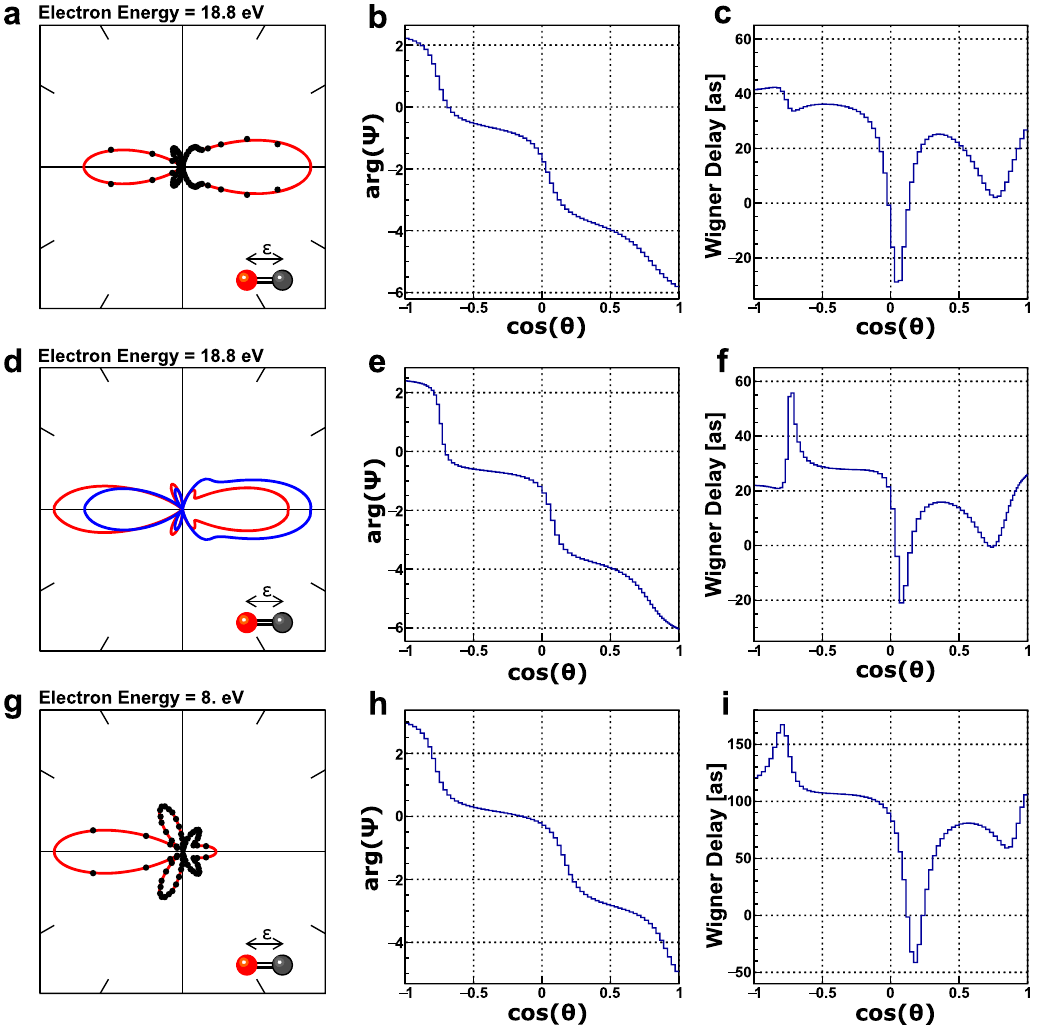
Fig. 2 Molecular-frame photoelectron angular distribution and extracted information for ε = 18.8 eV and ε = 8.0 eV. a Example of the emission pattern of a core electron emitted from the carbon atom of a CO molecule (black dots) for an electron energy of ε = 18.8 eV. The electron has been ionized by linearly-polarized synchrotron light. The molecule is oriented horizontally and parallel to the polarization axis of the photons with the emitting carbon atom pointing to the right (as depicted by the inset). The rich angular features are caused by the scattering of the emerging electron wave by the molecular (cid:1) (cid:3) potential. The statistical error bars of the data points are smaller than the markers. b The extracted phase arg Ψ ε ð θ Þ and c molecular-frame Wigner delay. The oxygen atom is located at cos ð θ Þ ¼ (cid:3) 1, the carbon atom at cos ð θ Þ ¼ 1. d – f Corresponding results obtained from our theoretical modeling of the photoemission process. The two lines in panel d belong to the modeling within the relaxed-core (red) and the frozen-core (blue) Hartree-Fock approximation. The phase and the Wigner delay shown in the panels e and f correspond to the relaxed-core Hartree-Fock approximation. g – i Experimental results obtained for an electron energy of ε = 8.0 eV, i.e., recorded on the Σ -shape resonance of the